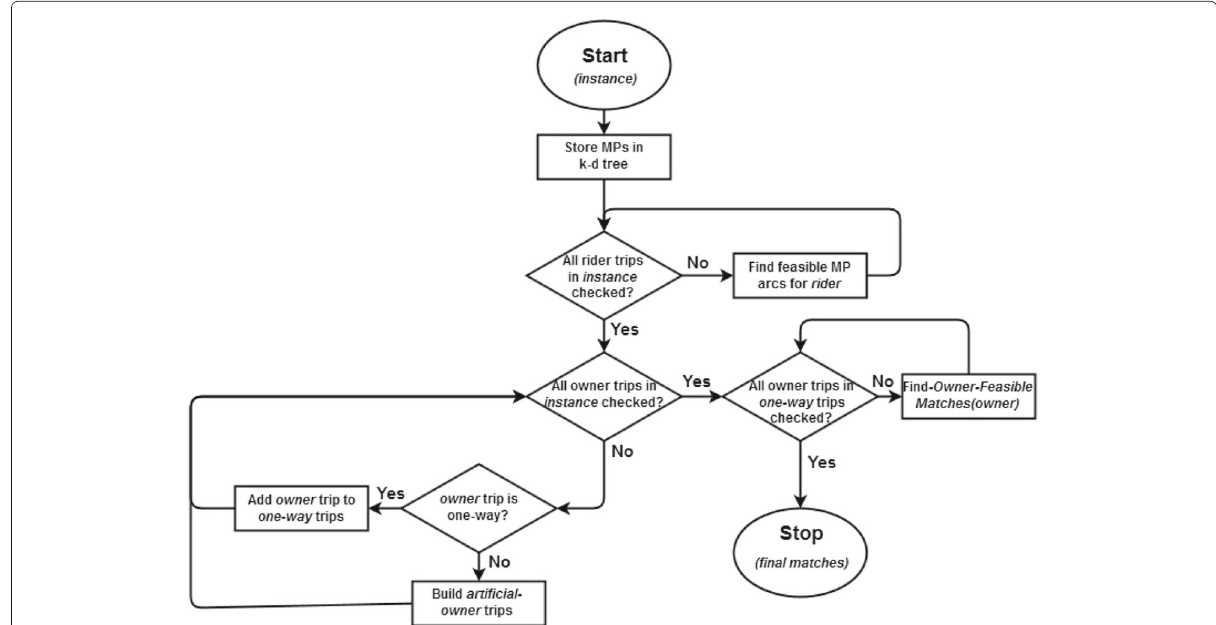
Fig. 6 Algorithm 2 -